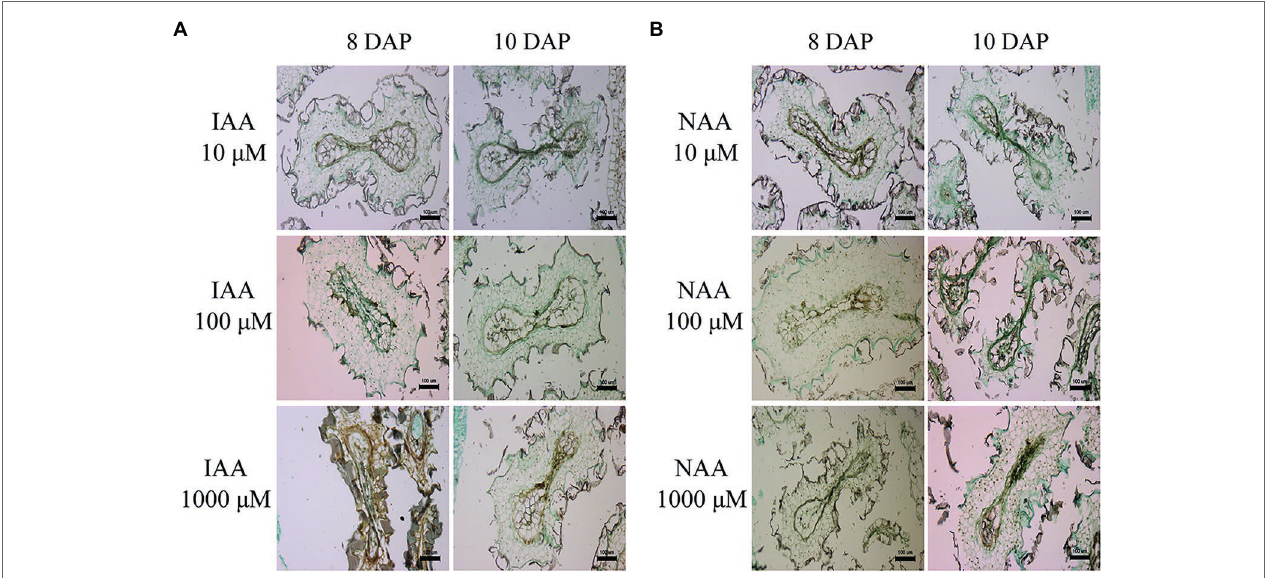
FIGURE 3 | Abnormal endosperm development and characteristics of type II hybrid seed lethality in the cross Nicotiana suaveolens PI 555565 (8x) × Nicotiana tabacum upon auxin treatment. (A) Seeds produced after IAA treatment. (B) Seeds produced after NAA treatment. Scale bars = 100 μ m. DAP, days after